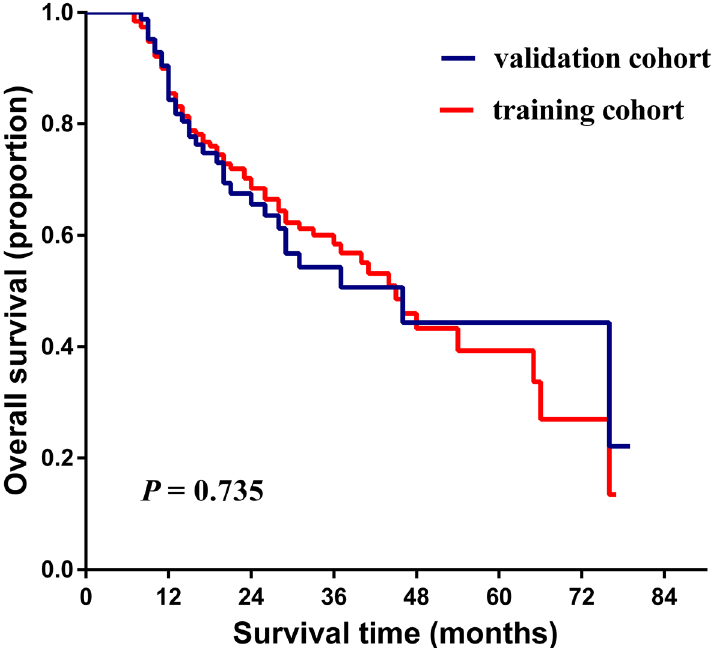
Figure 1. Kaplan–Meier estimate of the postoperative overall survival (OS) of patients with HCC stratified by different cohorts. The figure was performed using R software (version 3.3.1, https:// www.r- proje ct. org/).